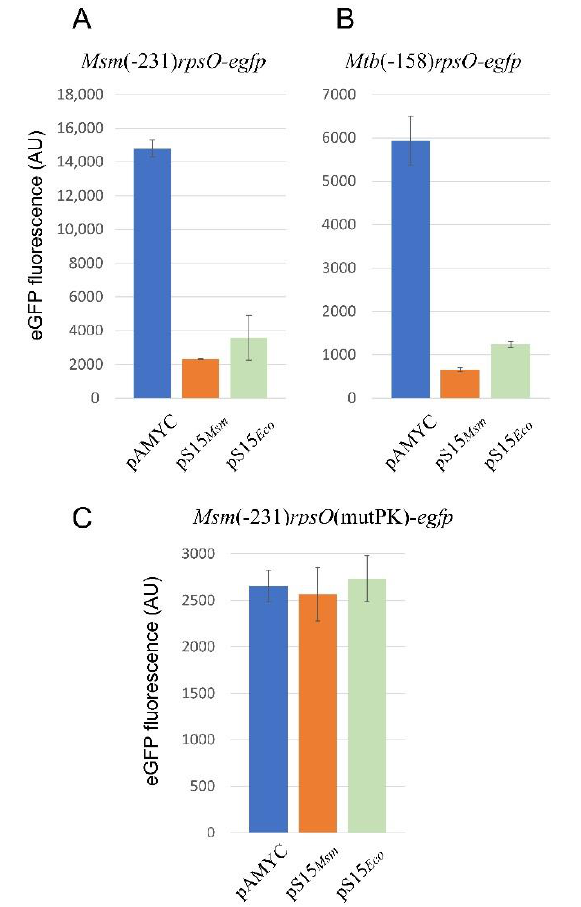
Figure 7. The rpsO genes of M. smegmatis and M. tuberculosis are feedback-regulated in vivo at the translation level. Repression of the Msm rpsO-egfp ( A ) and Mtb rpsO-egfp ( B ) expression in the presence of the pAMYC derivative expressing Msm S15 and E. coli S15. Results of fluorescent measurements of protein lysates from at least three biological replicates. ( C ) The pseudoknot is crucial for the regulation of the Msm rpsO-egfp reporter; changes preventing its formation (see Figure 4B) abolish the feedback regulation.